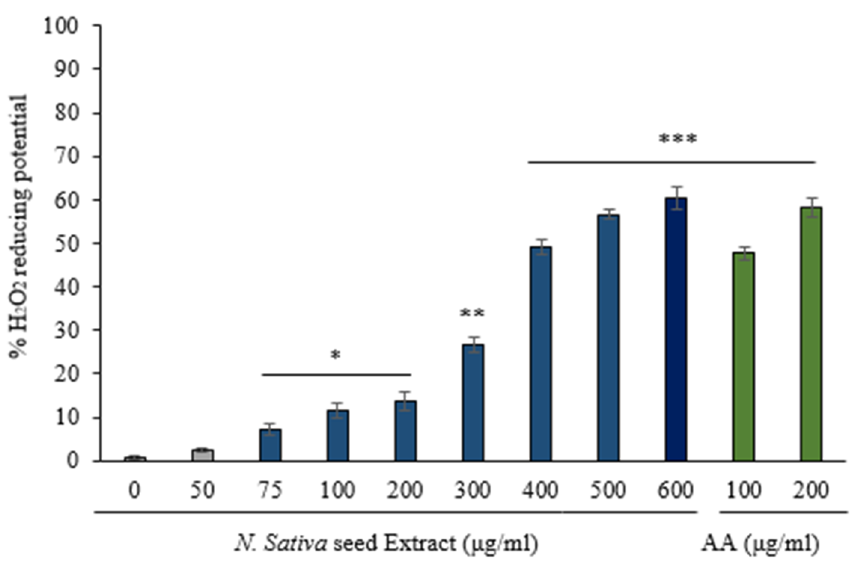
Figure 1. H 2 O 2 reducing potential of N. sativa seed extract. Ascorbic acid (AA) was used as the pos- itive control. The results are presented as means ± SEM ( n = 3). The statistical analysis was performed by using ANOVA (* p ≤ 0.05, ** p ≤ 0.01, *** p ≤